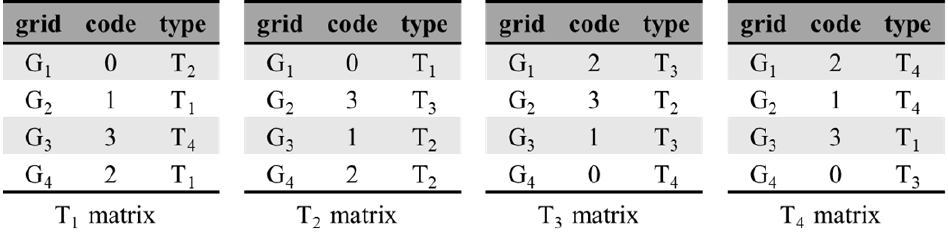
Algorithm 1 Hilbert code